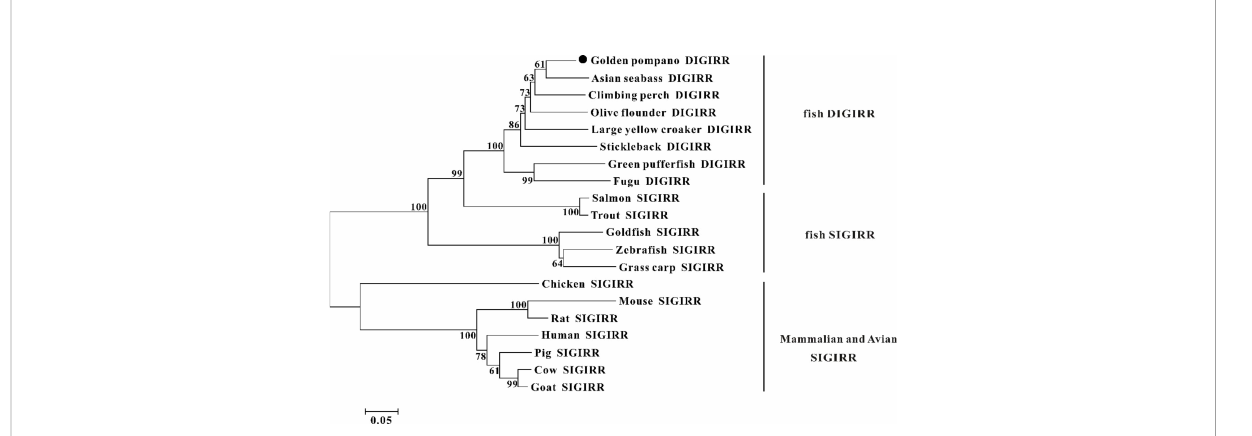
FIGURE 3 The phylogenetic tree of DIGIRR and SIGIRR genes in different species. The phylogenetic tree was constructed using the Neighbor-joining method (NJ) with 10000 bootstrapping replications by MEGA 7.0 software. The sequence information of all species was shown in Table 2.